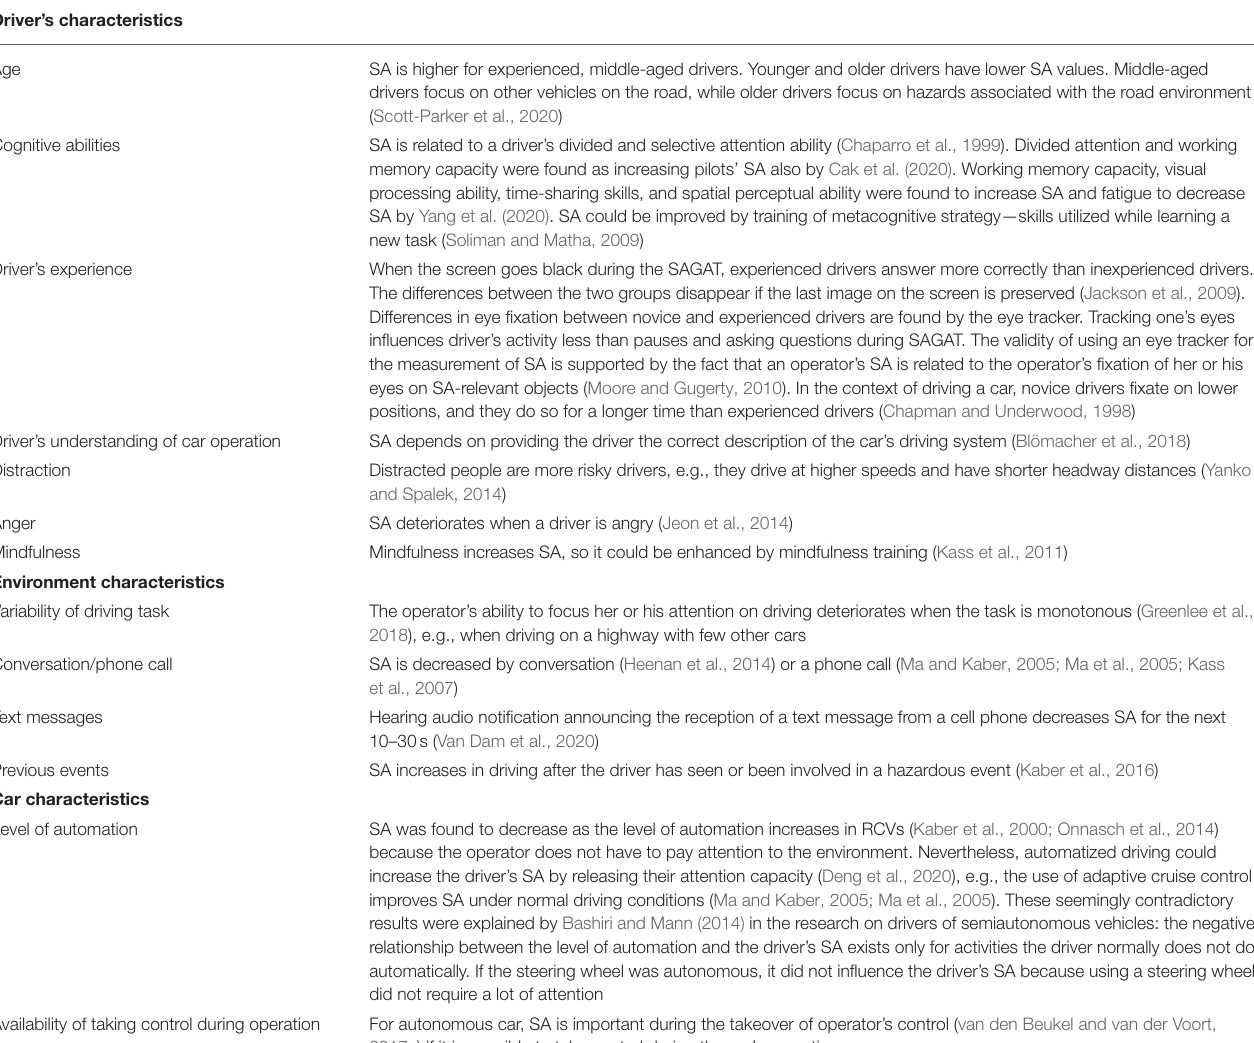
TABLE 1 | Driver, environment, and car characteristics that influence a driver’s situational awareness (SA). Driver’s